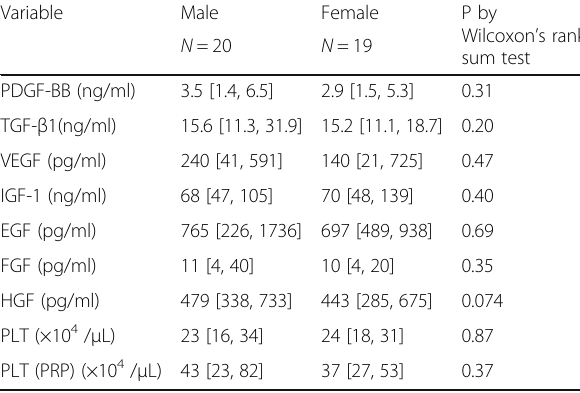
Table 3 Various factors ’ concentrations as a function of gender Variable